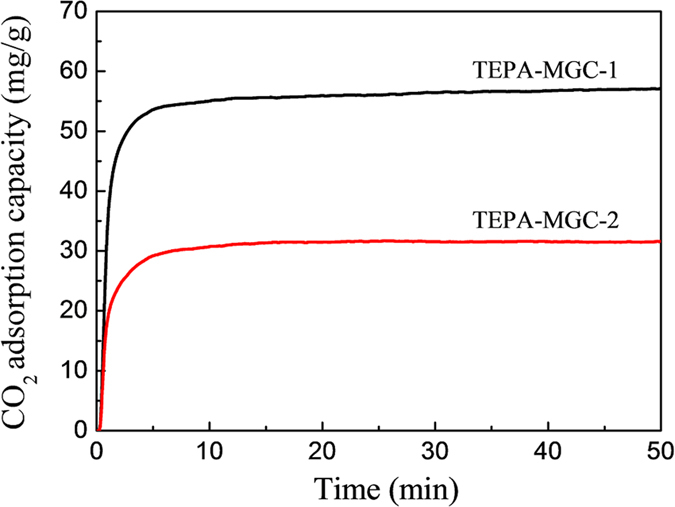
CO2 adsorption isotherms at 75 °C of the TEPA-MGC-1and TEPA-MGC-2.